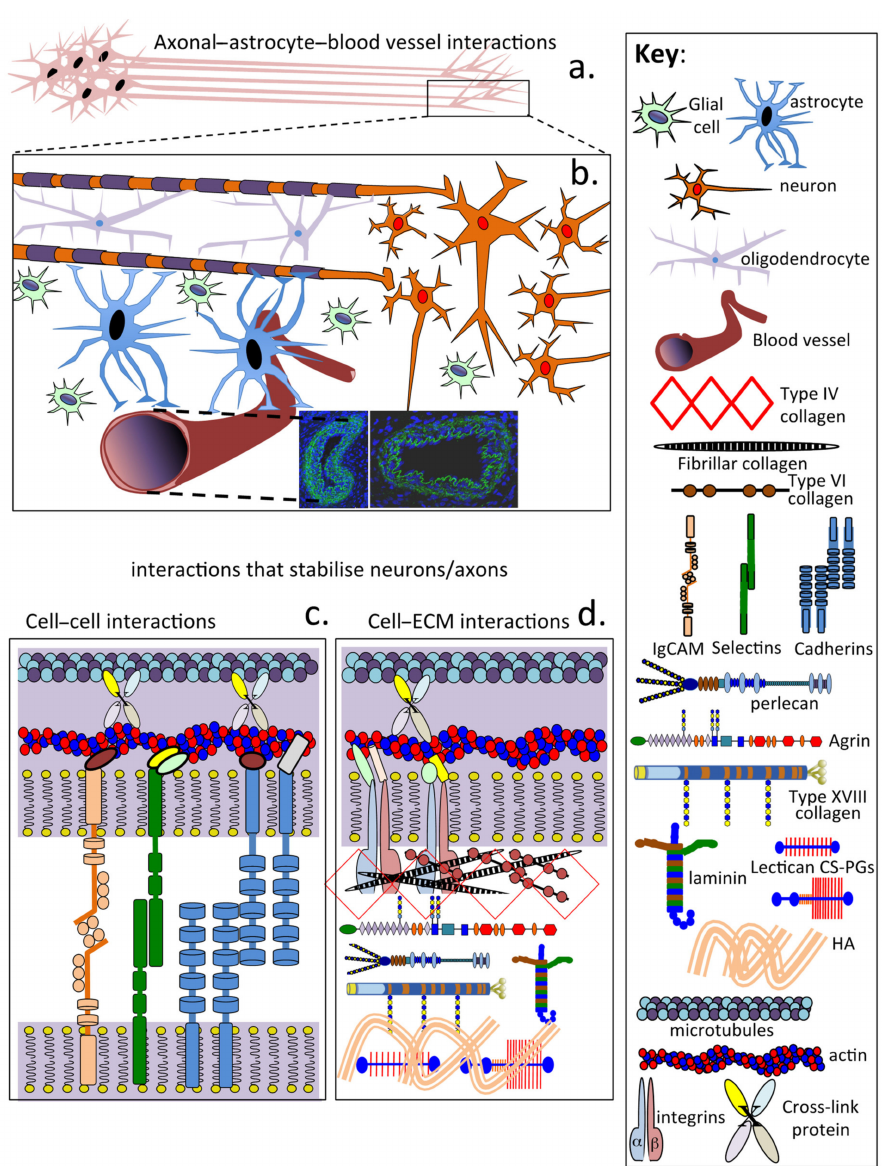
Figure 6. Schematic depictions of neuron axonal bundles ( a ) and the cellular and ECM